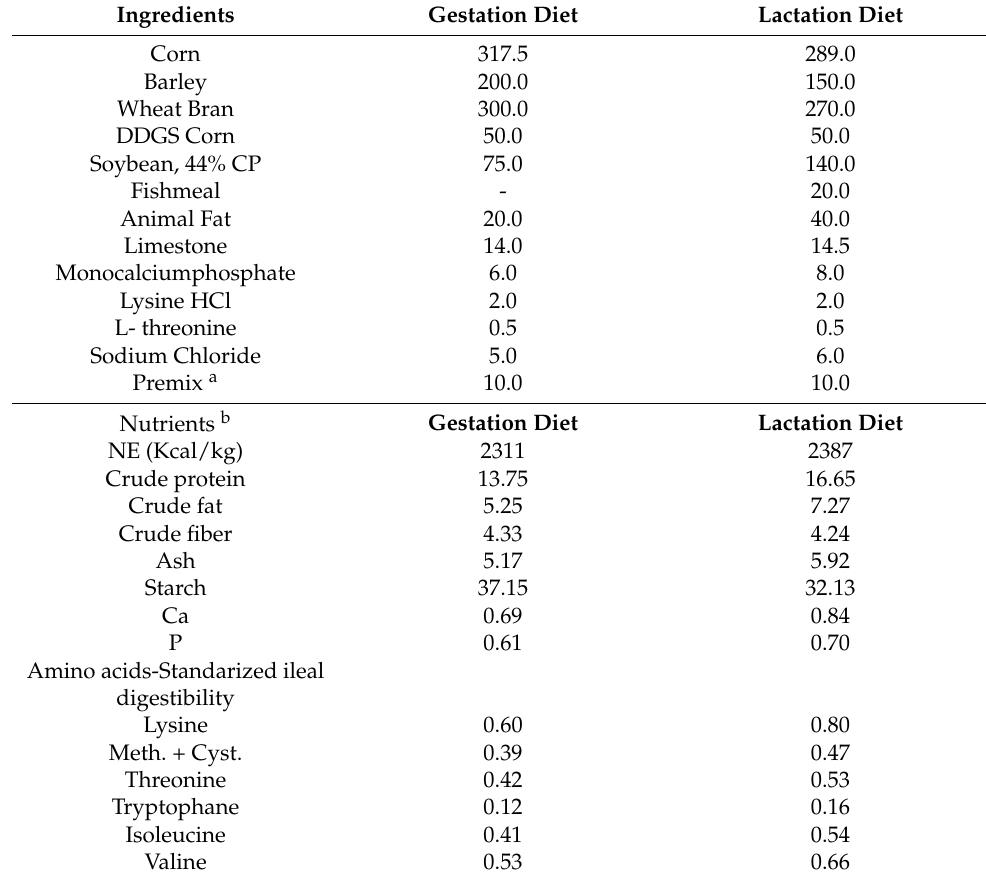
Table 1. Main ingredients (in kg/1000 kg) and nutrients (in %) of the gestation and lactation